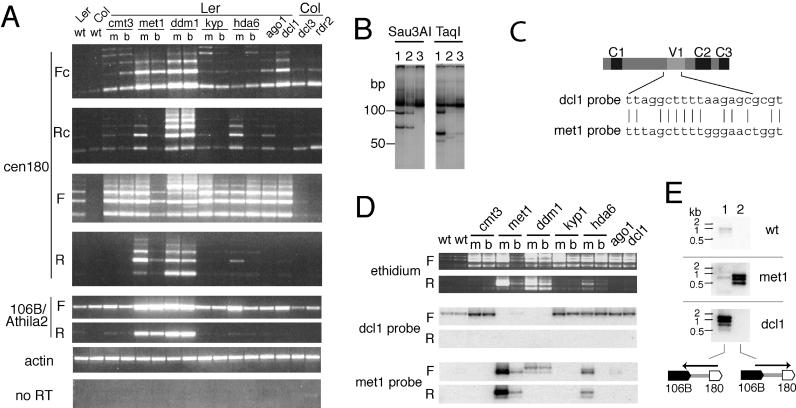
Regulation of Centromeric Transcripts(A) Strand-specific RT-PCR of cen180 repeats. RT was performed with forward and reverse primers indicated to the left of each panel. Mutants in DNA methylation (cmt3, met1), chromatin remodeling (ddm1), histone modification (kyp, hda6), and RNAi (dcl1, ago1) were in the Landsberg erecta (Ler) ecotype. rdr2 and dcl3 were in the Columbia background. m indicates homozygous mutants and b indicates backcrosses of mutants to WT (wt). Positive controls were primers recognizing the ACTIN2 gene; negative controls lacked reverse transcriptase (no RT).(B) Restriction site analysis of repeats. Repeats were amplified by cen180 F+R primers from genomic DNA (lanes 1), cDNA from met1 mutants (lanes 2), and cDNA from dcl1 mutants (lanes 3). Repeats in genomic DNA that have TaqI sites are not transcribed in either mutant, while those with Sau3AI sites are not transcribed in dcl1.(C) Oligonucleotide probes specific for the subfamilies of F + R cen180 repeats expressed in dcl1 and met1 mutants.(D) Strand-specific RT-PCR of cen180 repeats. RT was performed with F or R primers as in (A). Southern hybridization of these products with specific oligonucleotide probes distinguished subfamilies of repeats that were differentially regulated.(E) Detection of read-through transcripts between cen180 and 106B repeats by strand-specific RT-PCR. 106B Fout (lane 1) and cen180 F (lane 2) primers were used to prime cDNA, followed by PCR amplification. The configuration of the transcripts is shown below each lane. Other combinations of primers did not give detectable products. RNA was prepared from aerial tissues from 28-day-old plants.